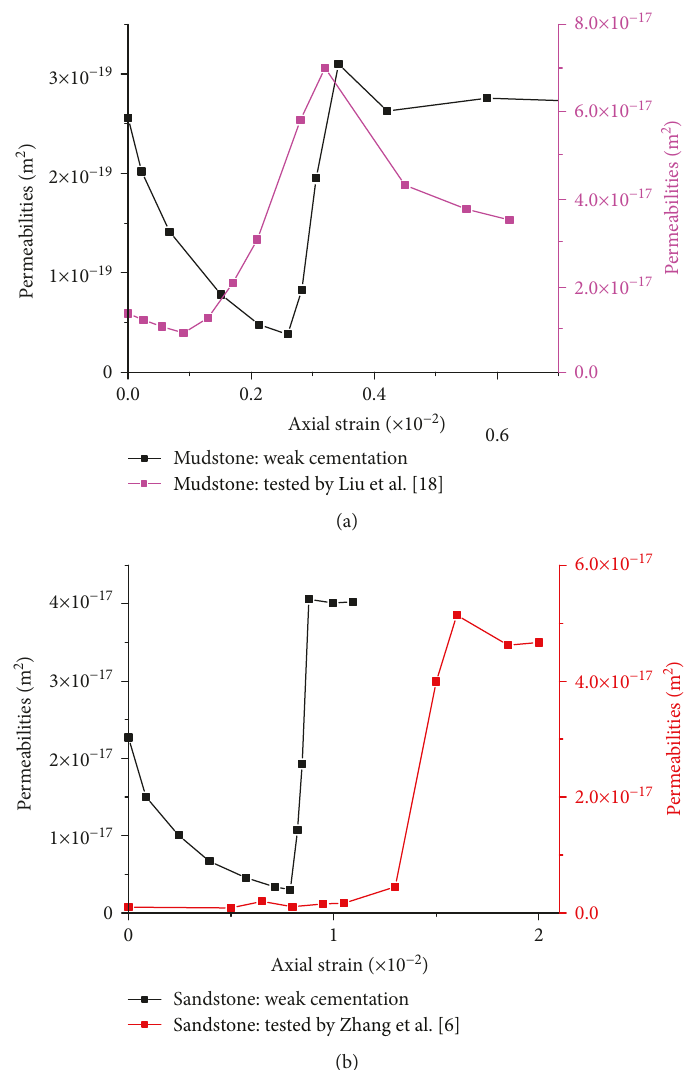
Figure 4: Permeability comparisons of weakly cemented rocks with common rocks of mudstone and sandstone, respectively.